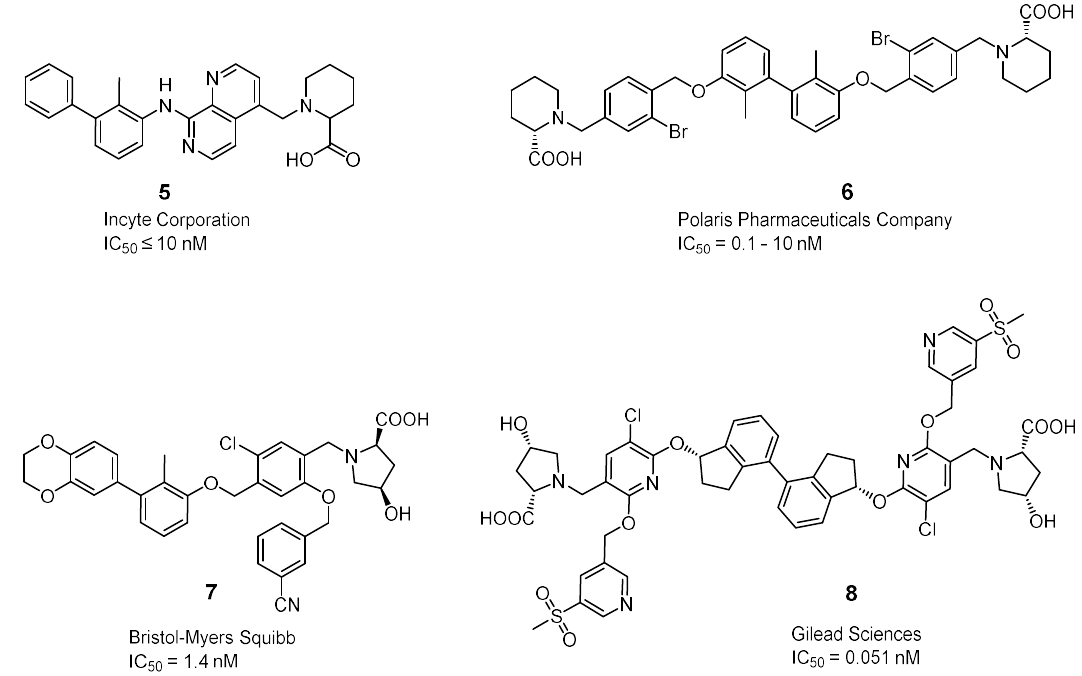
Figure 13. Examples of small molecule inhibitors targeting PD-L1, as disclosed by pharmaceutical companies [104,118–120]. companies